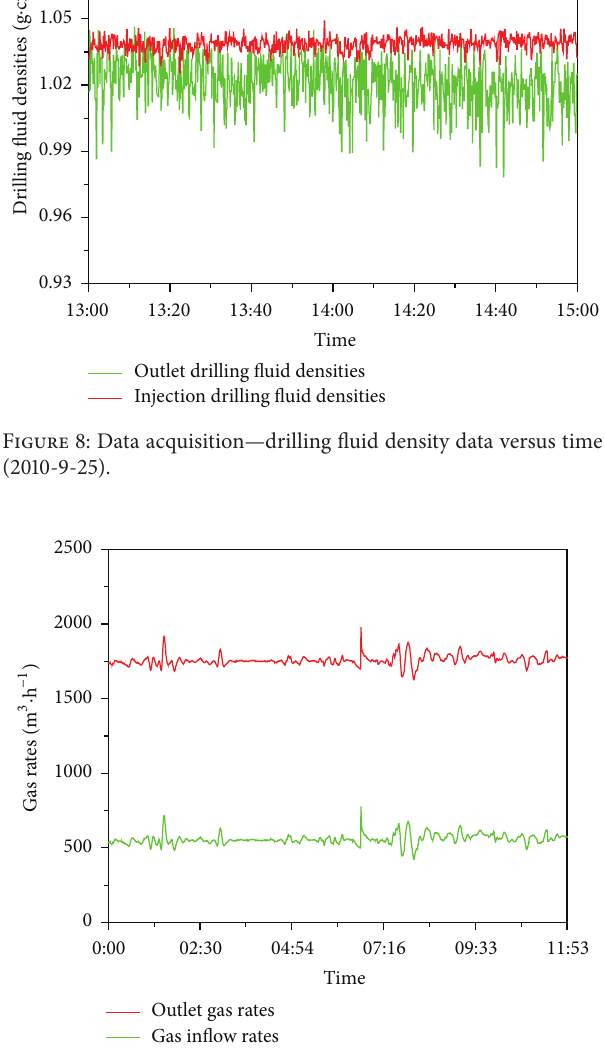
Figure 9: Data acquisition—outlet gas rates and gas inflow rates data versus time (2010-9-25).